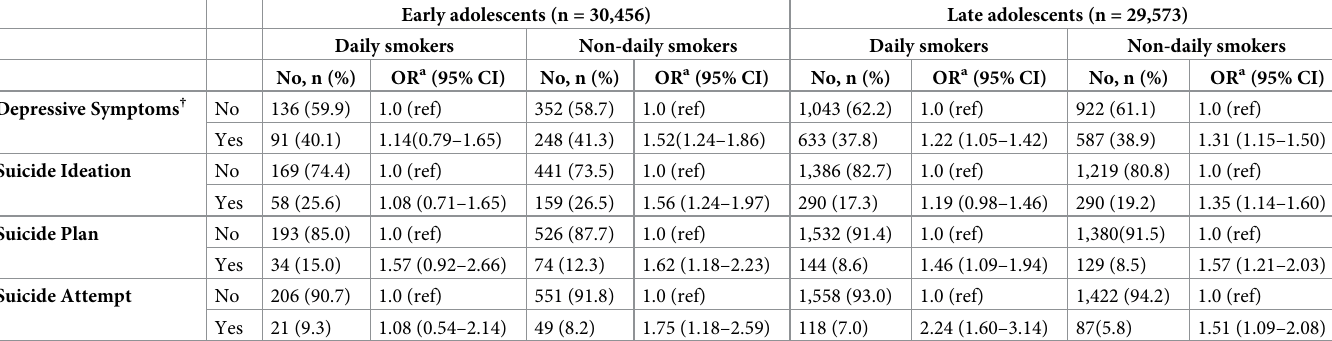
Table 3. Association between smoking patterns with depressive symptoms and suicidal behaviours (KYRBS, 2016, Korean adolescents aged 12–18